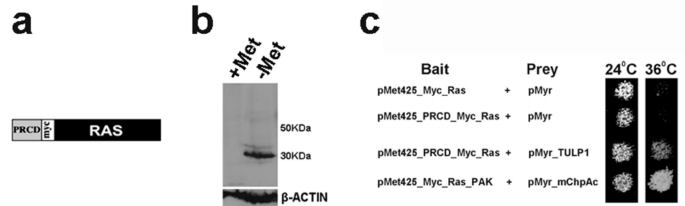
Figure 1. Identification of photoreceptor disc component (PRCD) interaction with TULP1 in yeast. ( a ) pMet425-PRCD-Myc-Ras bait construct used for the Ras recruitment system (RRS). The construct encodes for a chimeric protein, composed of mouse PRCD fused to a cytoplasmic Ras mutant, with a Myc tag at the C-terminus. ( b ) Western blot analysis of yeast transformed with the pMet425-PRCD-Myc-Ras bait construct, with an anti-Myc tag antibody, showing a 30 kDa band in yeast grown on media lacking methionine ( − Met). No band appears in the lane containing extract from yeast grown on methionine rich media ( + Met), indicating inducibility of the pMET425 promotor. ( c ) cdc25-2 yeast were co-transformed with the indicated bait and prey combinations, and grown on GAL–LUM plates incubated in the permissive (24 ◦ C) and the restrictive (36 ◦ C) temperatures. Co-transformations of yeast with empty bait and prey vectors (1st row) or with the PRCD-bait vector and an empty prey vector (2nd row) served as negative controls. Pak and ChpAc are two proteins known to interact with each other [21], and thus served as a positive control (4th row). Yeast transformed with a combination of PRCD and TULP1 (3rd row) grew at both the permissive and the restrictive temperatures, therefore indicating an interaction between these